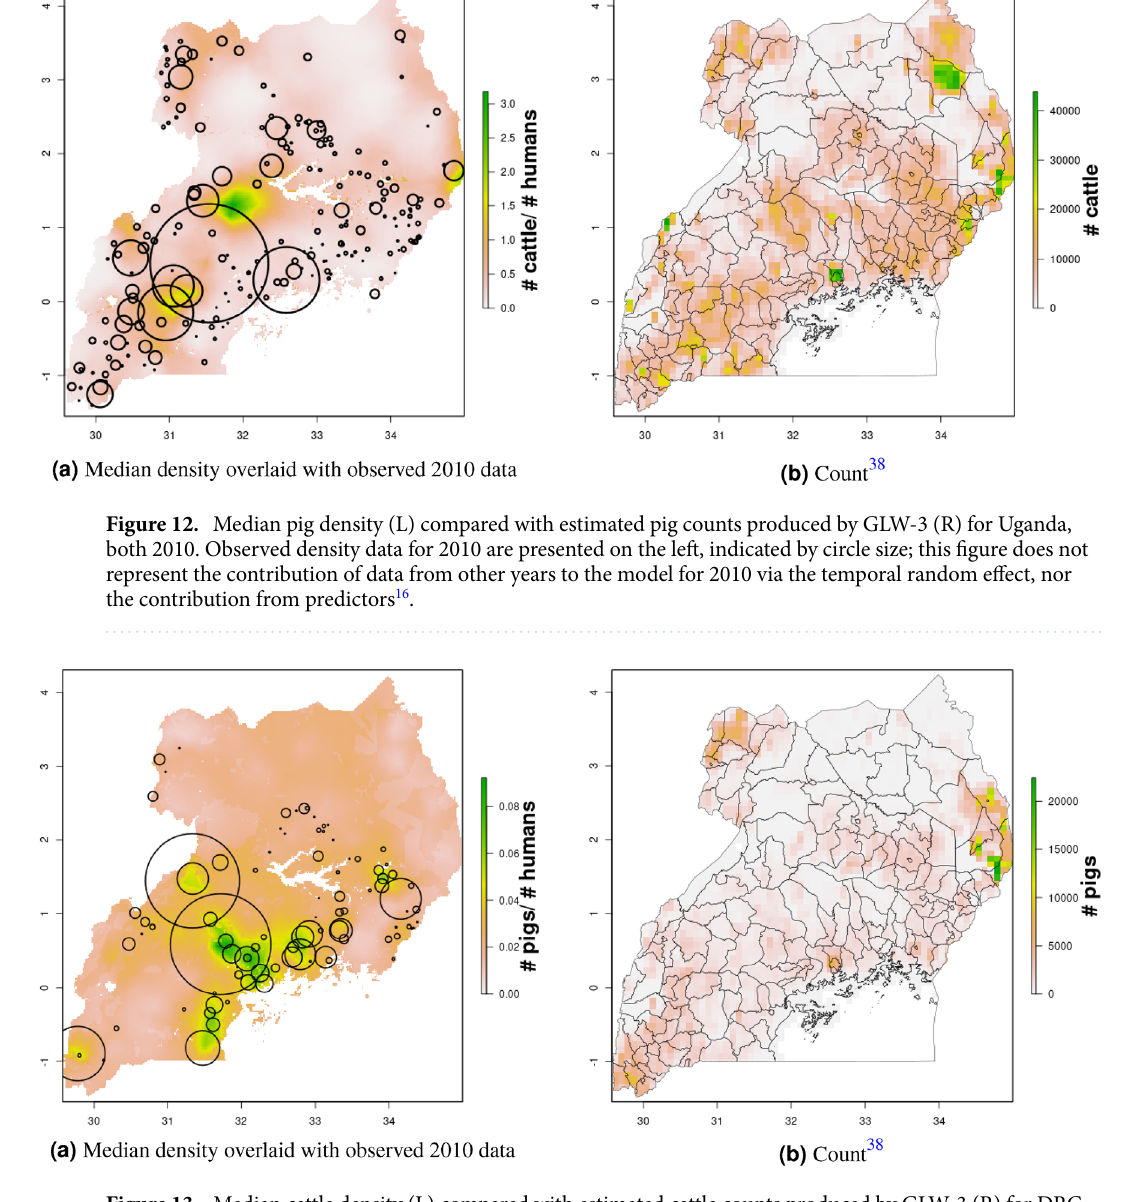
Figure 13. Median cattle density (L) compared with estimated cattle counts produced by GLW-3 (R) for DRC, both 2010. Observed density data for 2010 are presented on the left, indicated by circle size; this figure does not represent the contribution of data from other years to the model for 2010 via the temporal random effect, nor the contribution from predictors 16